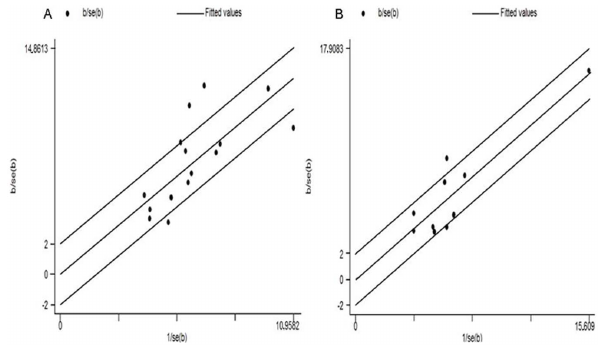
Figure 2. Galbraith plots of the association between b 2AR Arg16Gly polymorphism and asthma. A) Asian population subgroup; B) caucasian population subgroup. Four studies # maybe the main contributors to the heterogeneity Asian population subgroup; One studies # maybe the main contributors to the heterogeneity Asian population subgroup.